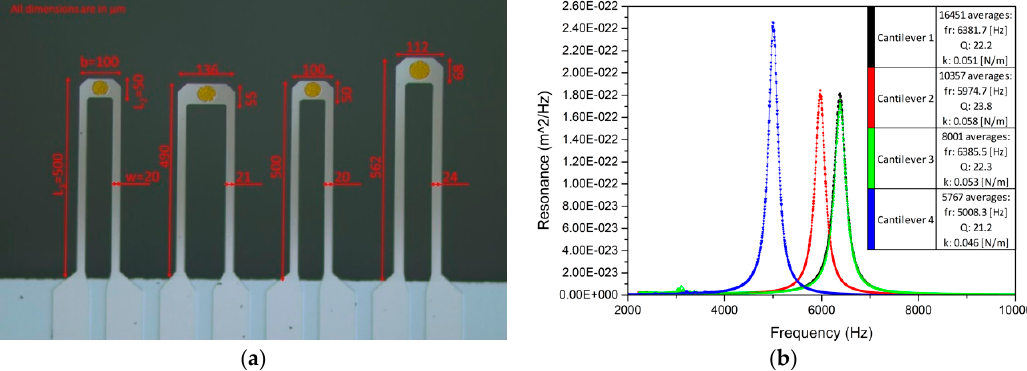
Figure 5. ( a ) example of manufactured cantilever array consisting of four cantilevers. Cantilevers 1 and 3 (from left to right) correspond to the initial design, while 2 and 4 are the optimal cantilevers after optimizations Opt2fz and Opt3. ( b ) the resonance response of the manufactured cantilevers.